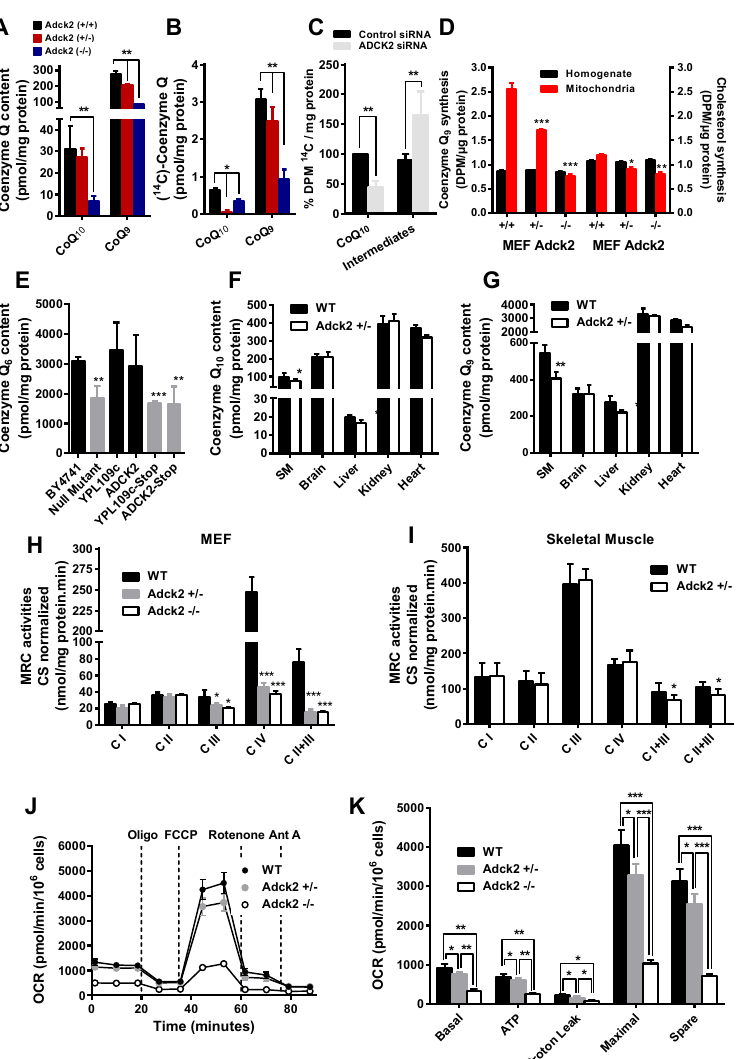
Figure 3. Coenzyme Q content and MRC activities in cells and tissues. CoQ 9 and CoQ 10 content ( A ) and biosynthesis ( B ) in mice embryonic fibroblasts (MEFs) isolated from Adck2 − / − , Adck2 +/ − and WT mice ( n = 5). ( C ) Effect of siRNA silencing of ADCK2 on the rate of CoQ 10 biosynthesis, measured by incorporation of 14 C- p -hydroxybenzoate ( 14 C- p -HB) intermediate, in MRC5 human fibroblasts ( n = 4). ( D ) Levels of CoQ (first three sets of bars) and cholesterol (second three sets of bars) produced in the presence of 3 H-mevalonate in total homogenates and mitochondrial fractions from MEFs. ( E ) CoQ 6 content in BY4741 WT and ∆ YPL109c (null mutant) yeast strains after transformation of ∆ YPL109c with YPL109c WT or human ADCK2 . Also, ∆ YPL109c was transformed with mutant alleles of either YPL109c ( YPL109c -stop) or ADCK2 (ADCK2-stop) ( n = 7). The content in CoQ 10 ( F ) and CoQ 9 ( G ) was determined in various tissues and organs of Adck2 +/ − and WT mice ( n = 5). MRC activities normalized to citrate synthase in MEFs ( H ) and skeletal muscle ( I ) of both WT and Adck2 +/ − mice. ( J ) and ( K ) Oxygen consumption rate (OCR) in WT, Adck2 +/ − and Adck2 − / − MEFs. Bars are mean + SD. Data was analyzed by using repeated-measures ANOVA test. ( n = 5); * p < 0.05, ** p < 0.01, and *** p < 0.005 vs.